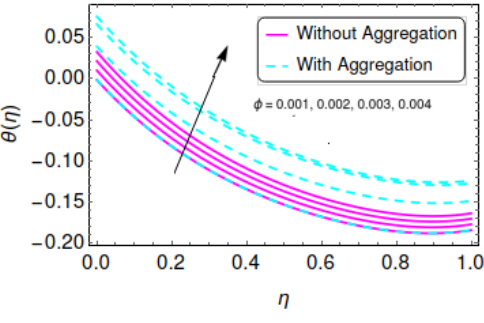
Figure 22. The result of φ on θ ( η ) . The skin friction noticed enhance for higher values of Re r , ß 1 , ß 2 for both disks while it reduce for by higher λ 1 can be seen in Table 4. It can be observed from Table 5 that the transfer of heat is reduces by greater values of Re r , Pr , B 1 and λ 2 at both disc. Table 4. Skin friction for higher vales of Re r ,ß 1 ,ß 2 and λ 1